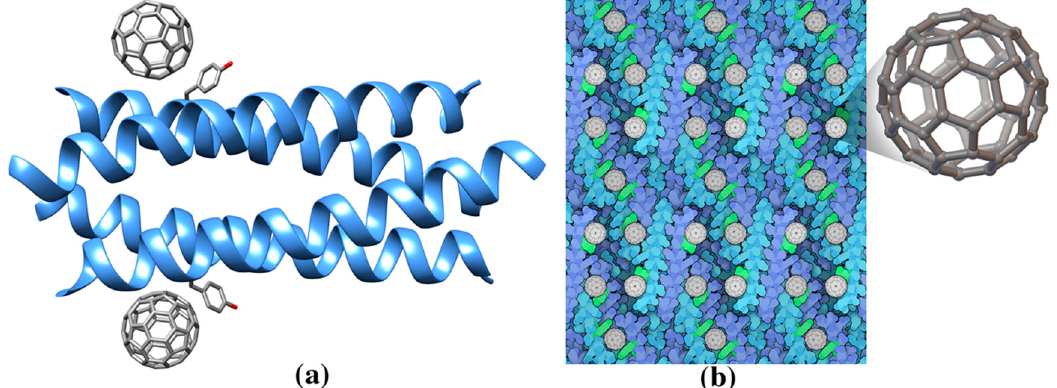
Figure 2. ( a ) Ribbon drawing of the de novo designed protein COP (C60-organizing peptide) in complex with fullerene (pdb entry 5et3). ( b ) COP protein in complex with fullerene forms a large superstructure. Each fullerene molecule is bound to two four helix bundles through the side chain of a Tyr residue (green). This figure is obtained from the Molecule of the Month column “Proteins and Nanoparticles” (pdb101.rcsb.org/motm/222). Inset: fullerene molecule from the crystal structure of COP-fullerene complex (gray spheres, cif code 60C).